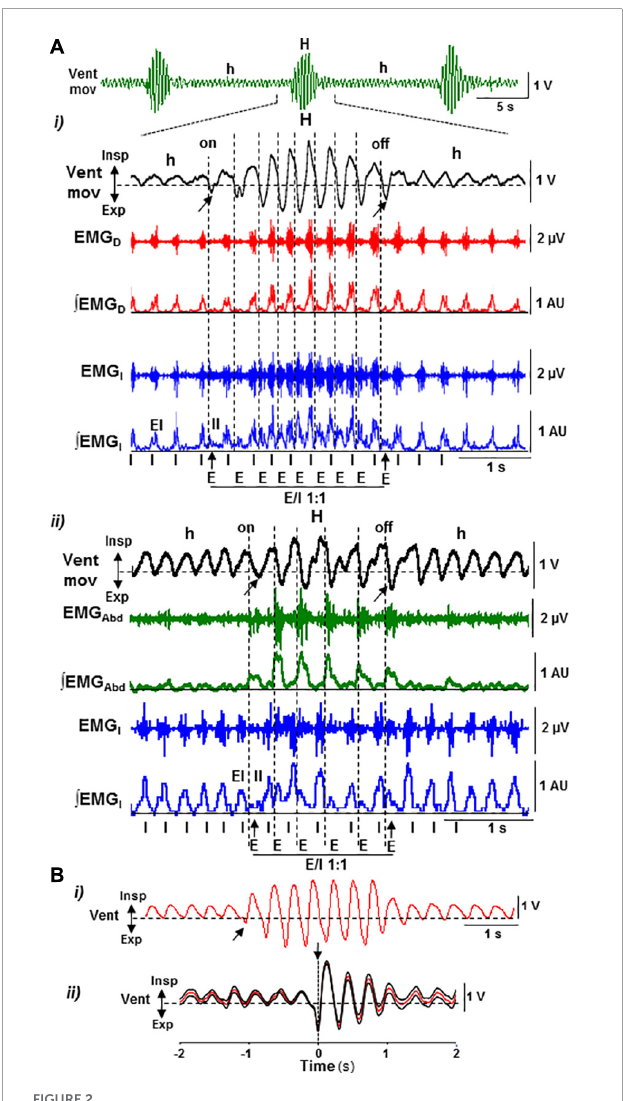
FIGURE2 Motor pattern of periodic Cheyne–Stokes breathing in the postnatal Cx36KO mouse model. (A) CSB motor pattern underlying recurrent epochs of hypopnea and hyperpnea ( Vent Mov , h, and H ) oscillates between an inspiratory driven rhythm ( I ) of low intensity and synchronous in the diaphragm ( EMG D , R EMG D ) and external intercostal muscles ( EMG I , R EMG I , EI ) during hypopnea epochs and a dual expiratory ( E ) and inspiratory ( I ) motor activity coupled in an antiphase ratio 1:1 ( E/I 1:1 ), due to the additional expiratory activation of the internal intercostal ( EMG I , R EMG I , II ) and oblique abdominal muscles ( EMG Abd , R EMG Abd ) during hyperpnea epochs (i,ii). Note that the epochs of hyperpnea initiate and terminate by an active expiration (arrows). (B) Sample trace of ventilatory motion and averaged signal synchronized with the first active expiration during hyperpnea epochs (i,ii, arrows; N = 30 epochs) showing that the function of active expiration is to force exhalation and increase the following